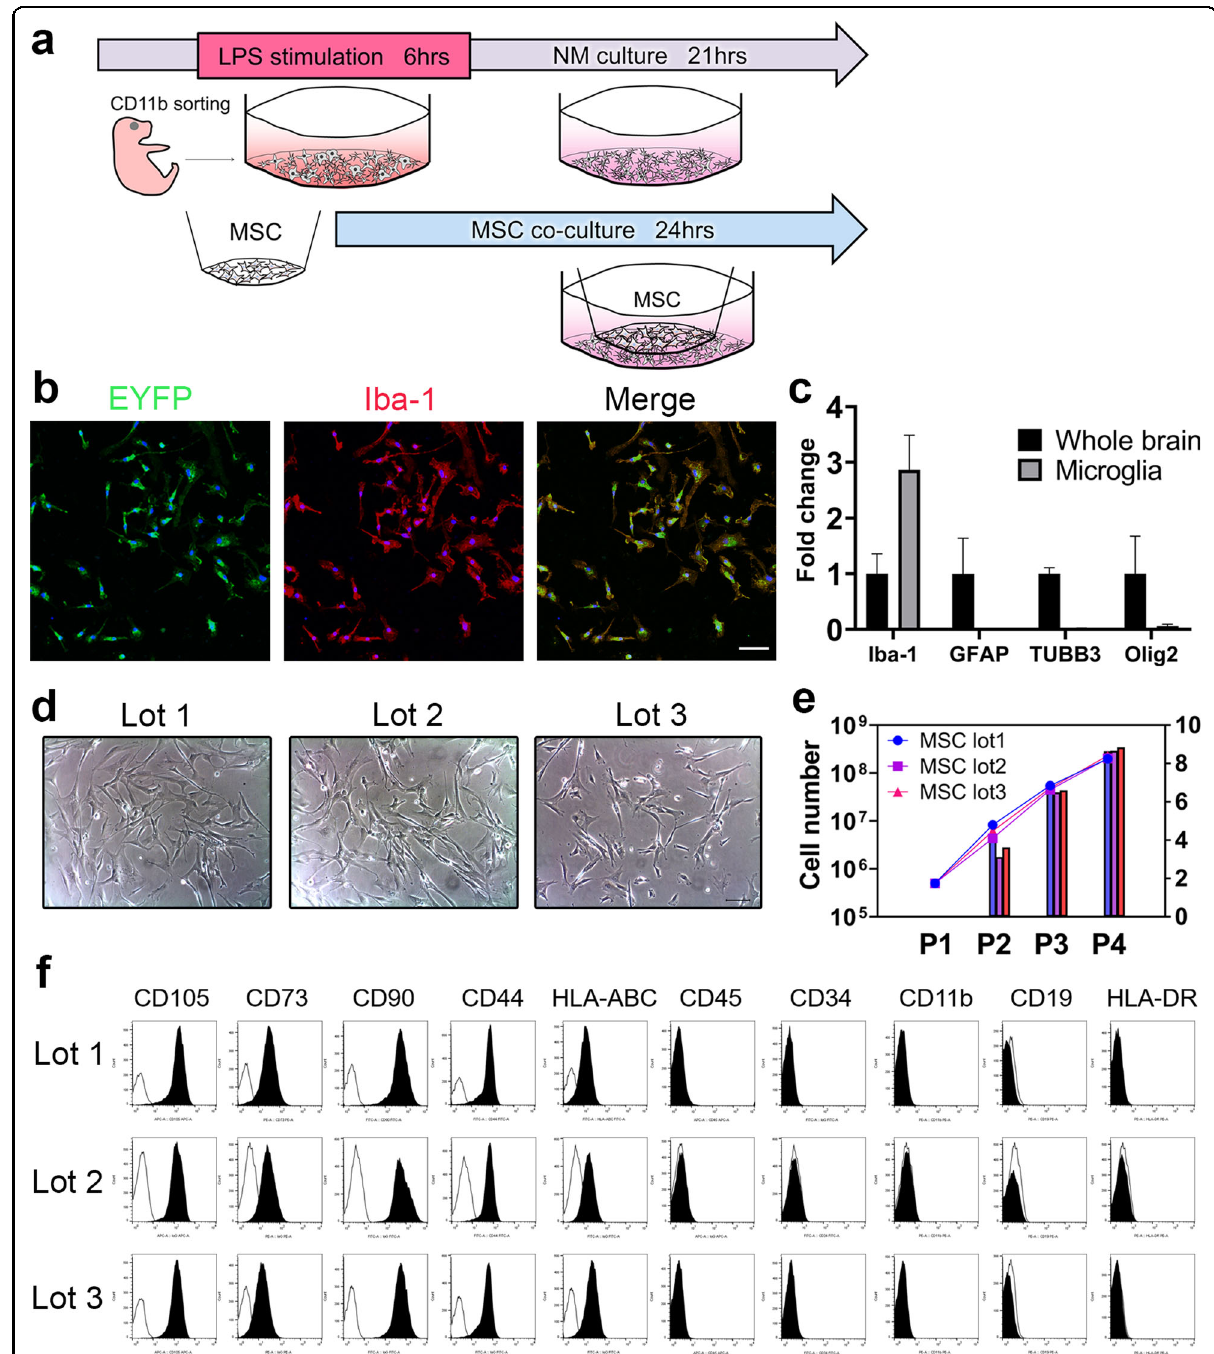
Fig. 1 Experimental design and characteristics of primary culture of microglia and 3 lots of MSC. In this experiment, microglia were stimulated with LPS for 6 h and backed to culture in NM. In LPS + MSC group, co-cultured with MSC was started 3 h after LPS stimulation. The same procedure was performed without LPS stimulation for NM and NM + MSC groups ( a ). Immunocytochemistry of EYFP stained with anti-GFP antibody (green), Iba-1 (red) and Hoechst 33342 (blue) (scale bar = 50 μ m) ( b ). The expression of Iba-1, GFAP, TUBB3 and Olig2 in microglia normalized to whole brain tissue by qPCR ( c ). Phase contrast images of 3 lots MSC (scale bar = 100 μ m) ( d ). Cell number (line) and PDL (bar) of 3 lots MSC ( e ). Surface markers of MSC that positive for CD73, CD105, CD90, HLA-ABC, and CD44, and negative for CD45, CD34, CD11b, CD 19 and HLA – DR ( f ). Abbreviation: NM: normal medium, PDL: population doubling